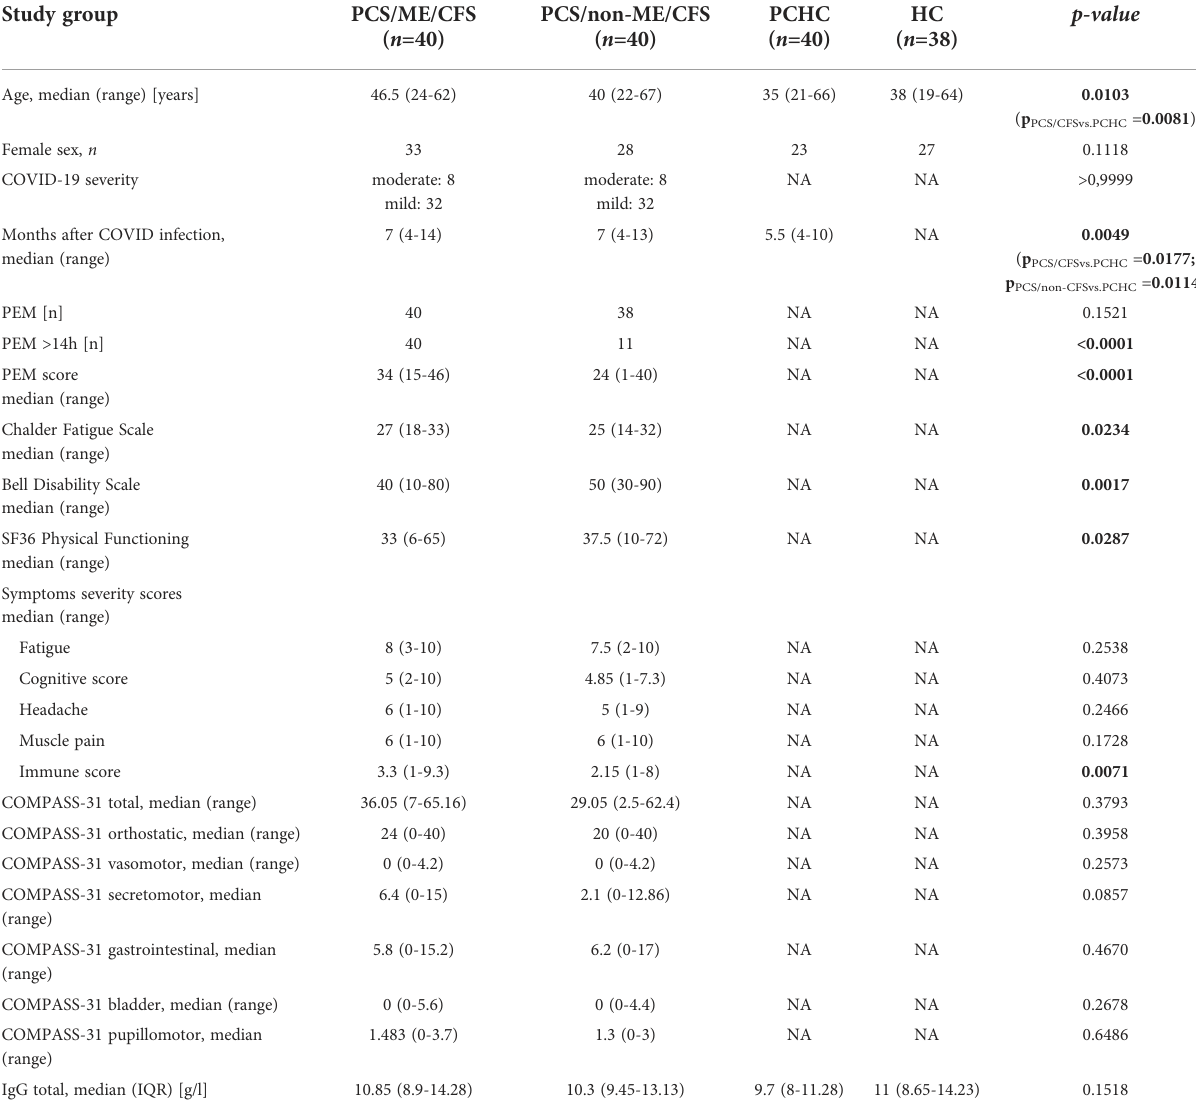
TABLE 1 Characteristics of study